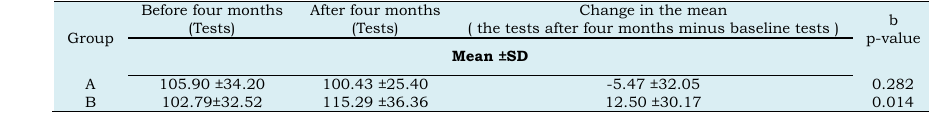
Table 2 Comparison of LDL (mg/dl) concentrations before and after four months.